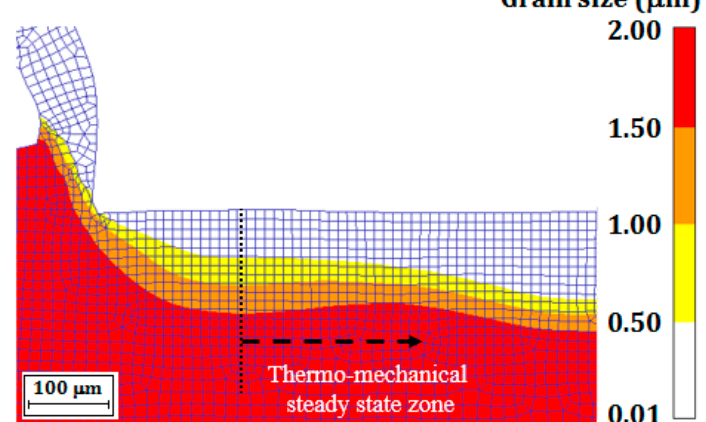
Figure 3. Grain size prediction: positive rake fresh insert with cutting speed (UP-F/V) = 273 m/min.